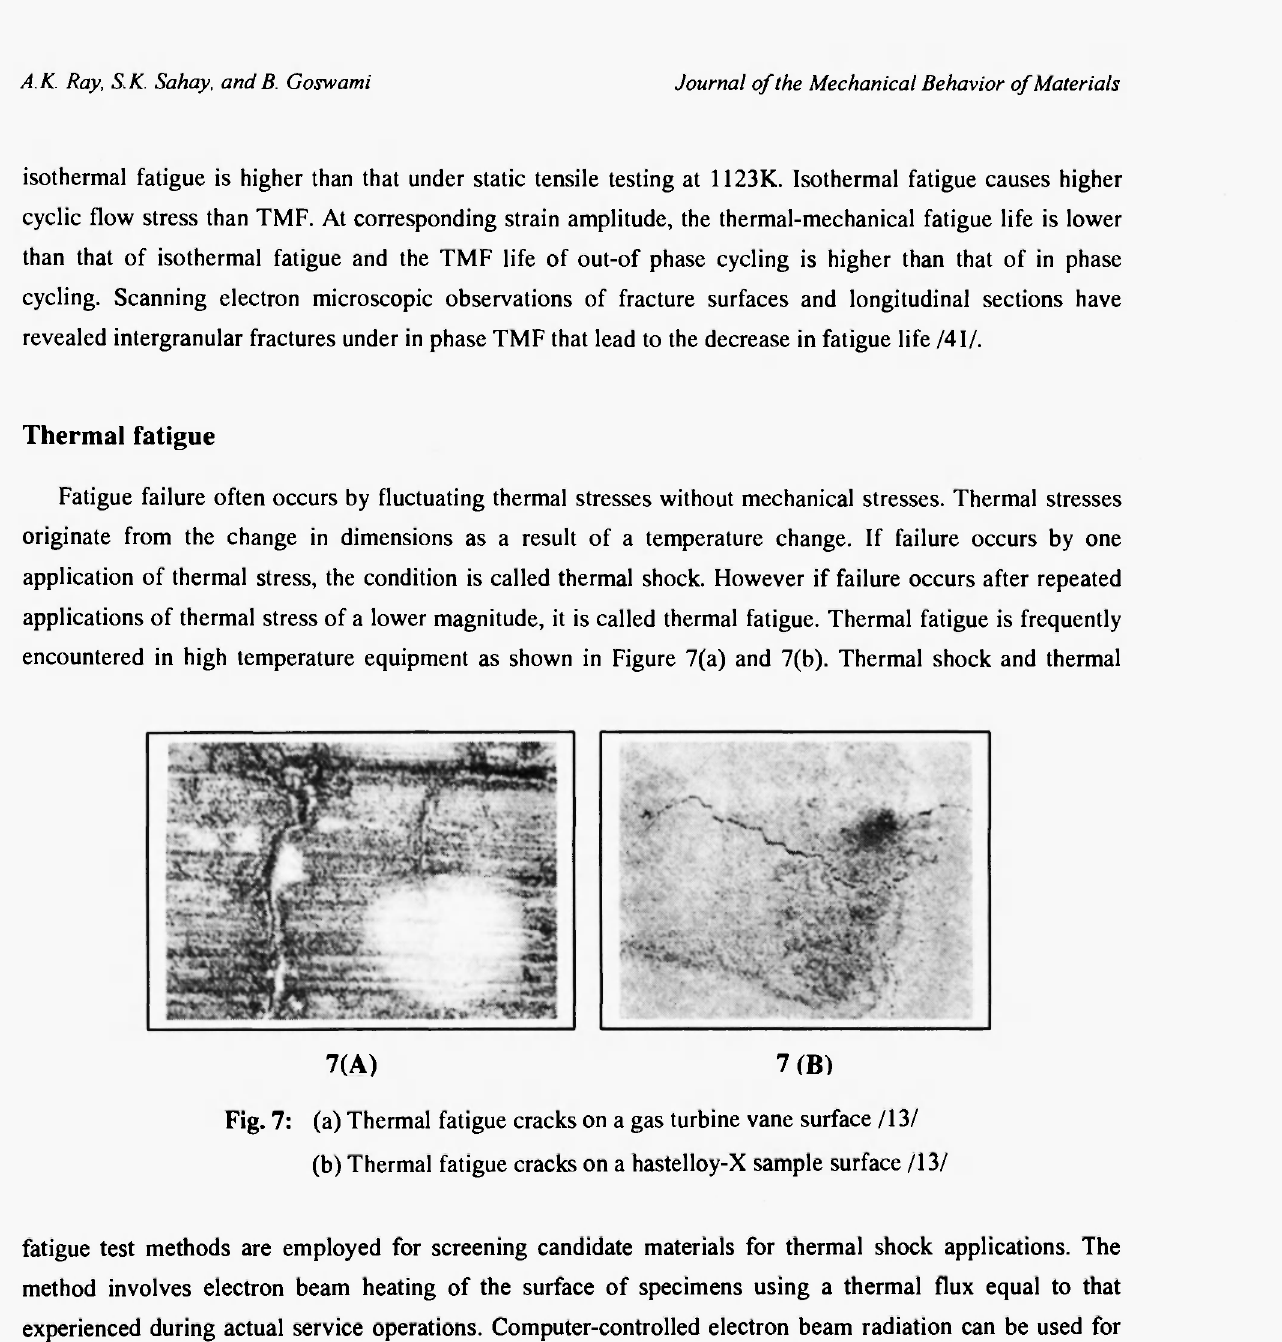
Fig. 7: (a) Thermal fatigue cracks on a gas turbine vane surface /13/ (b) Thermal fatigue cracks on a hastelloy-X sample surface